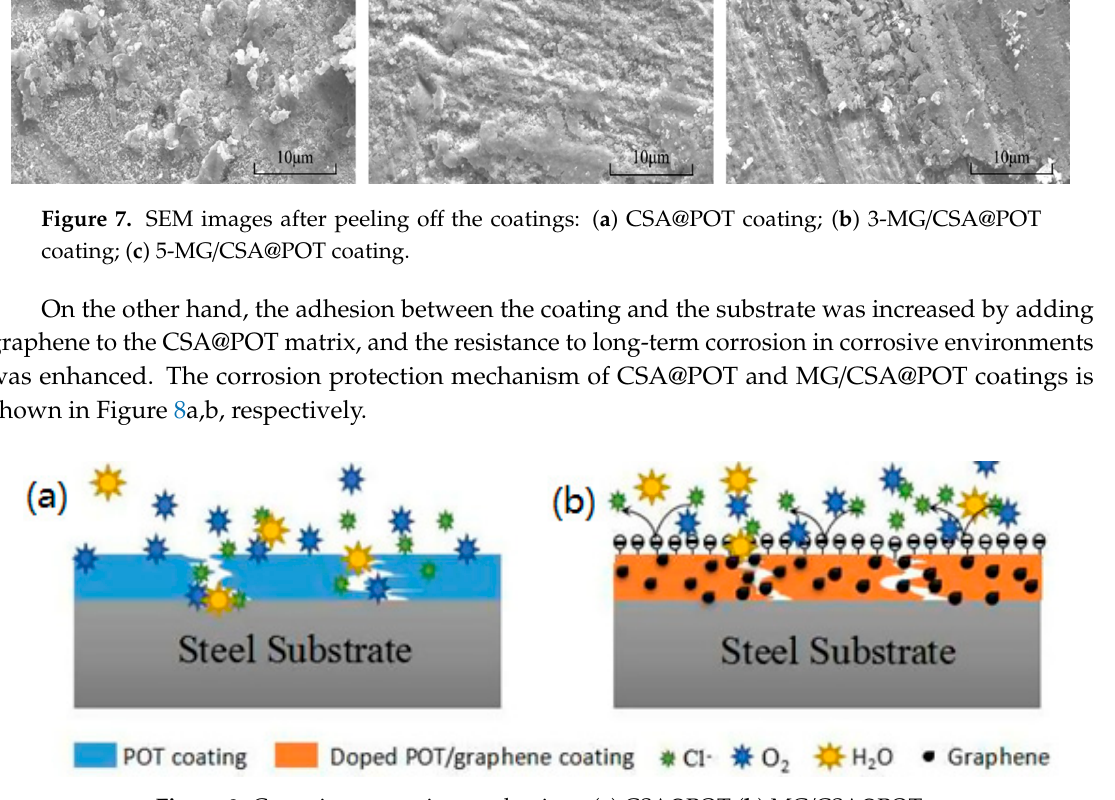
Figure 8. Corrosion protection mechanisms (a) CSA@POT (b) MG/CSA@POT.